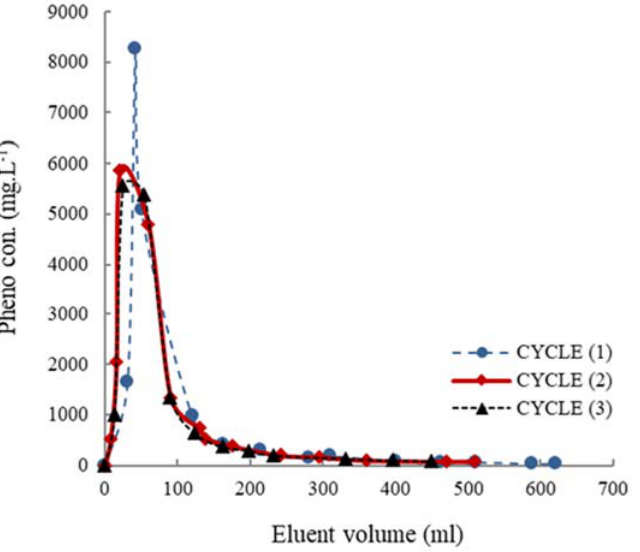
Figure 7. Desorption cycle profile of phenol at a rate of flow of 8 mL/min & bed depth of 8.5 cm with 0.1 M NaOH as eluent.